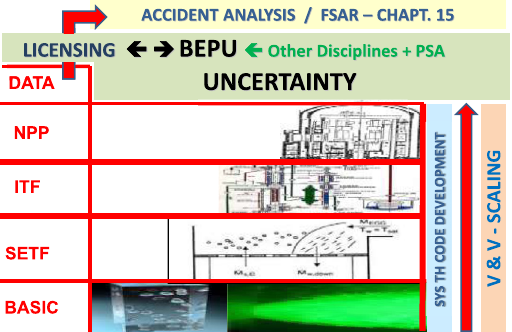
Fig. 1. The BEPU process focusing on Accident Analysis and Chapter 15 of FSAR (NOTE: Acronyms and symbols in the fi gure not de fi ned in the paper are, in alphabetic order: ITF= Integral Test Facility; SETF=Separate Effect Test Facility; SYS TH= System Thermal-Hydraulics; V & V=Veri fi cation and Valida- tion; Ṁ ECC =Mass fl ow-rate of injected Emergency Core Cooling; Ṁ fl ow-rate penetrating the core; Ṁ w,COND =Condensed mass S, fl ow-rate of steam and gas; T G = Upward mass sat = saturation temperature; T w = water